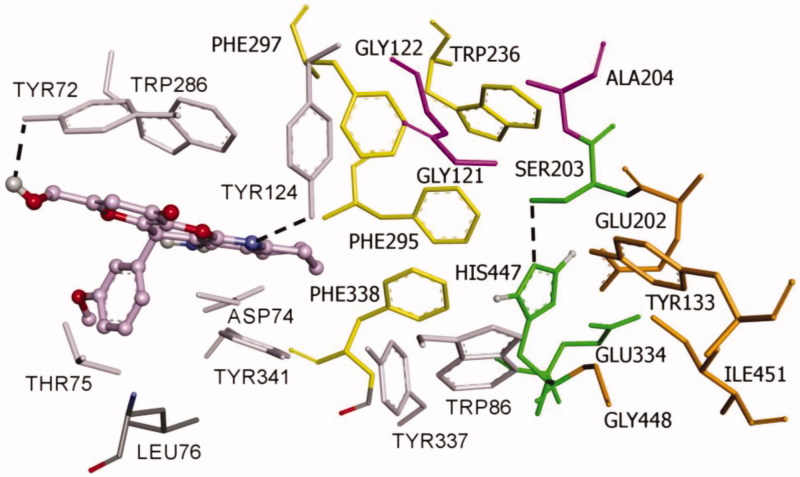

Binding mode of inhibitor (R)-KT2d at the active site of hAChE. Compound (R)-KT2d is pictured as ball and sticks in pink and the side chains of the mobile residues are represented in the pale pink. The sub-sites of the active site were coloured: oxyanion hole (OH) in fuchsia, anionic sub-site (AS) in orange, except Trp86, acyl binding pocket (ABP) in yellow, catalytic triad (CT) in green and PAS in light violet. Hydrogen bond interactions are represented as dashed black lines.